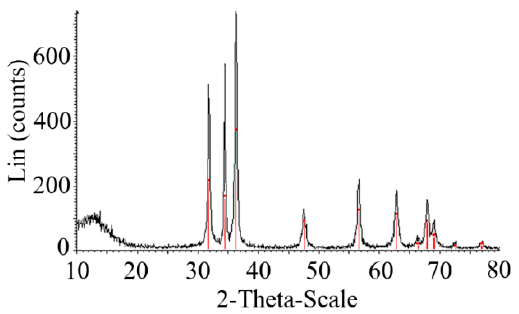
Figure 3. X-ray diffraction (XRD) spectra of XG-capped ZnO microstars.